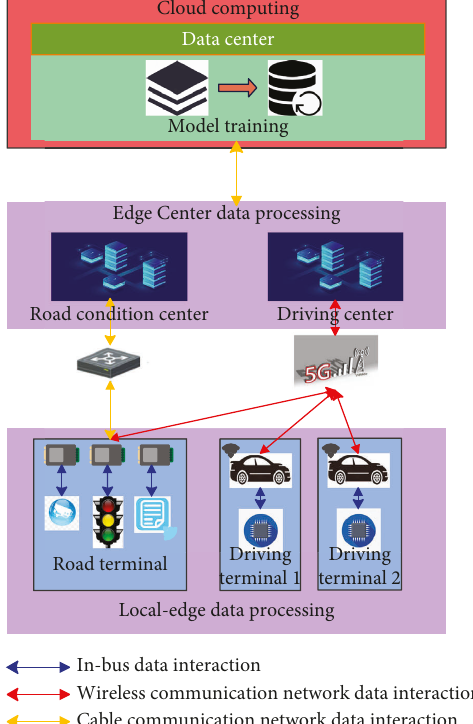
Figure 5: Schematic diagram of the process of edge computing in the field of smart transportation applications.